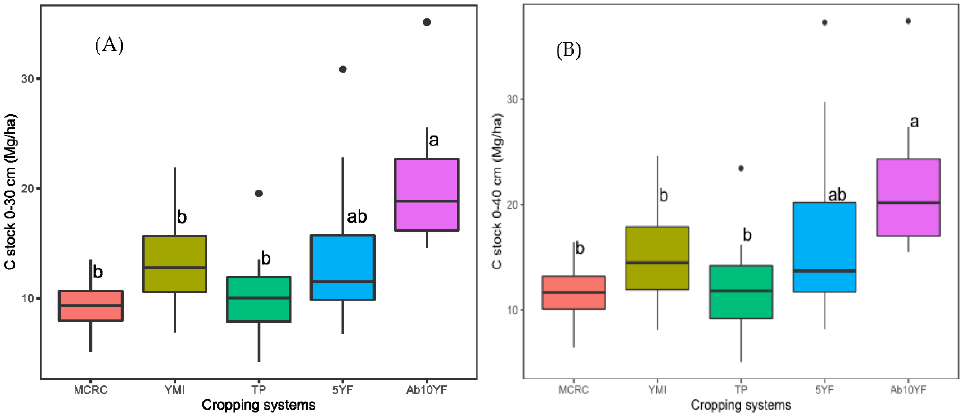
Figure 2. Total carbon stock for soil layers 0–30 cm ( A ) and 0–40 cm ( B ) MCRC: maize–cotton relay cropping; 5YF: 5-year fallow; Ab10YF: above 10-year fallow; YMI: yam–maize intercropping system; TP: teak plantation. Means that do not share a letter are significantly different at α = 0.05. Table 4. Carbon concentrations in particle size fractions across the cropping systems for 0–10 and 10–20